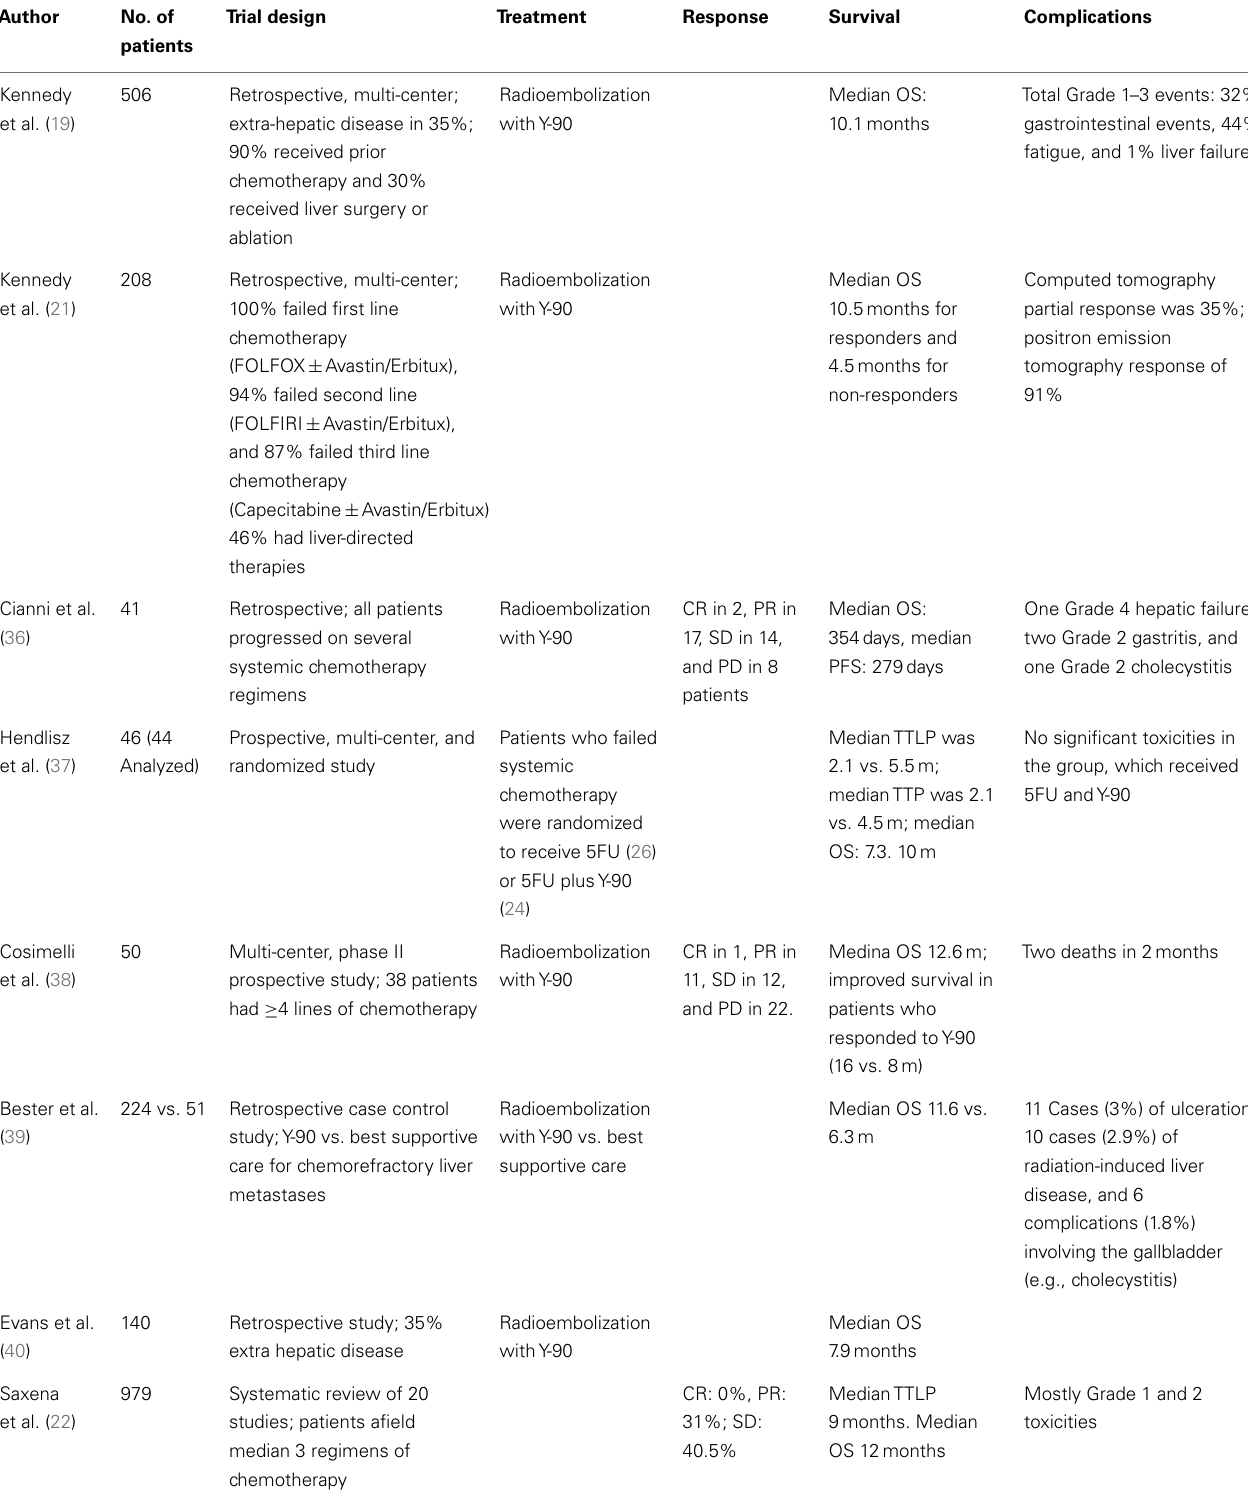
Table 4 |Yttrium-90 as salvage therapy for chemorefractory patients